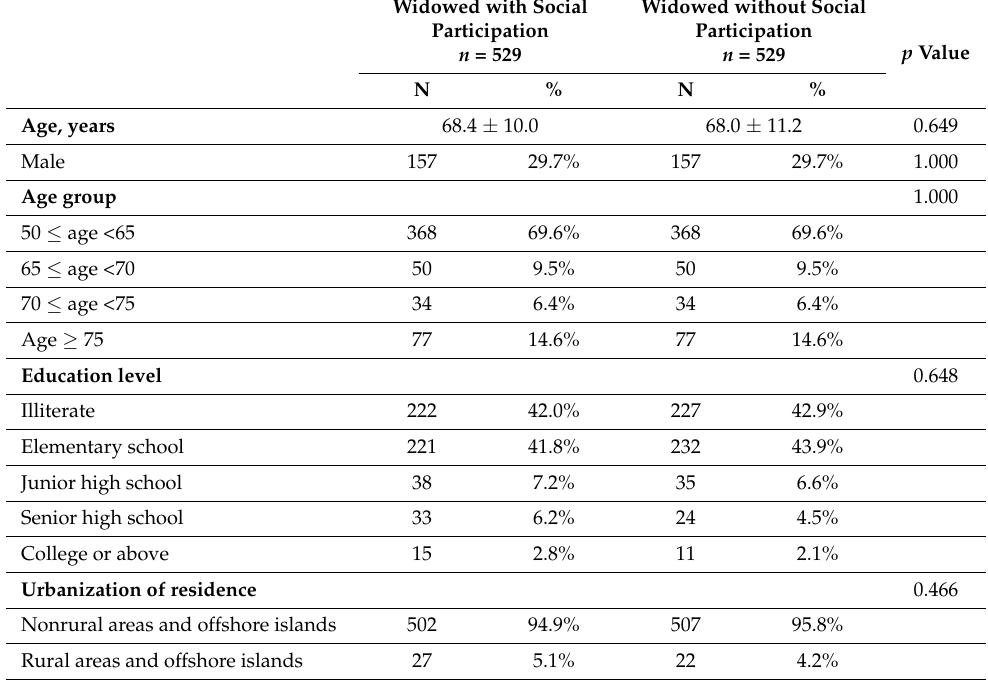
Table 3. Baseline characteristics of matched widowed participants with and without social participa-